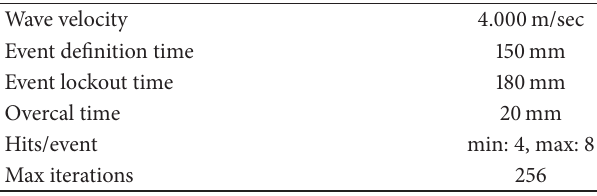
Table 3: AE localization setup.